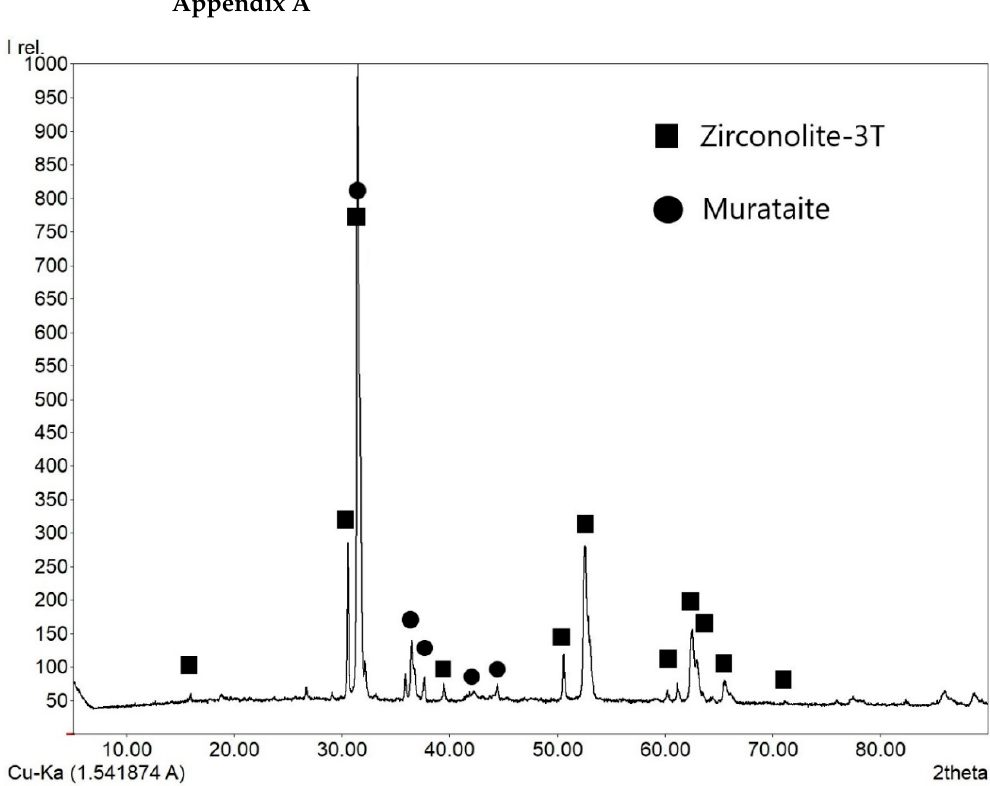
Figure A1. X-ray diffraction pattern of the sample “Th”.